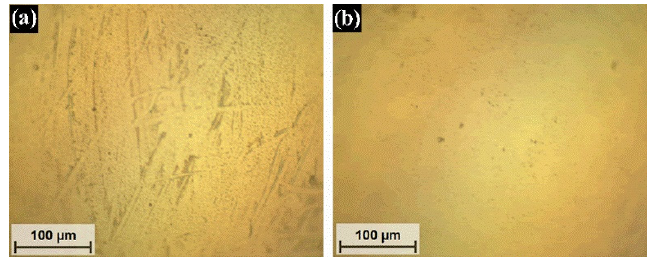
Figure 9. Micrographs (at 200×) of counterpart surfaces: tested ( a ) and untested ( b ).